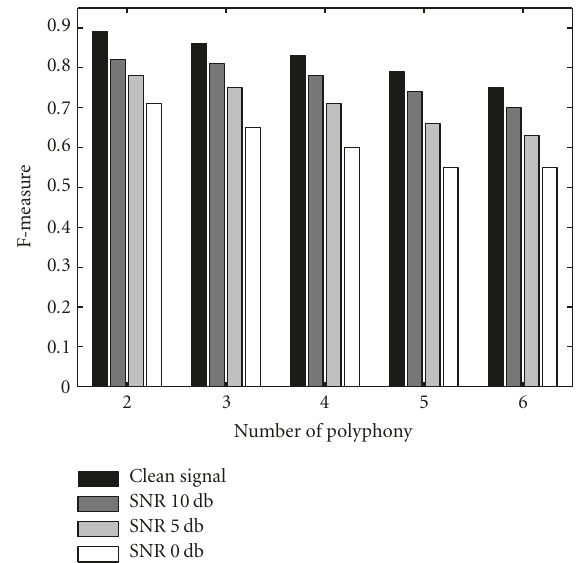
Figure 6: F-Measure of test results of the proposed method with a clean signal or various levels of added